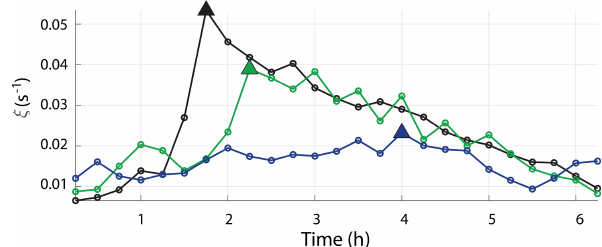
Figure 10. Time series of the maximum magnitude of vorticity at the strait exit, defined as the area where y u < y ≤ y e . The black, green, and blue curves represents the same three simulations shown in Figs. 5 to 7, respectively. The triangles mark the separation time.